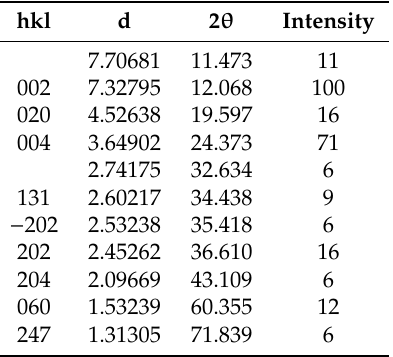
Figure 6. X-ray di ff raction (XRD) pattern of AC waste sample. Figure 6. X-ray diffraction (XRD) pattern of AC waste sample. Table 4. d hkl -spacing of Table 4. d hkl -spacing of clinochrysotile.